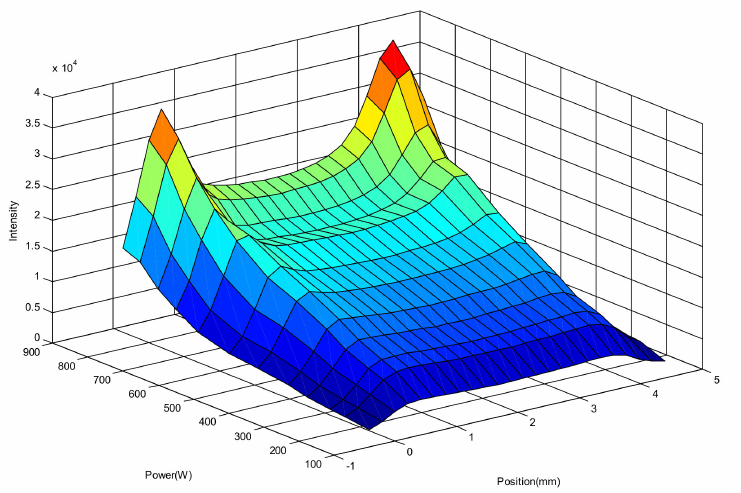
Figure 4. Three-dimensional view of the emission intensity vary with gap position and power of 4.4 mm argon DBD.